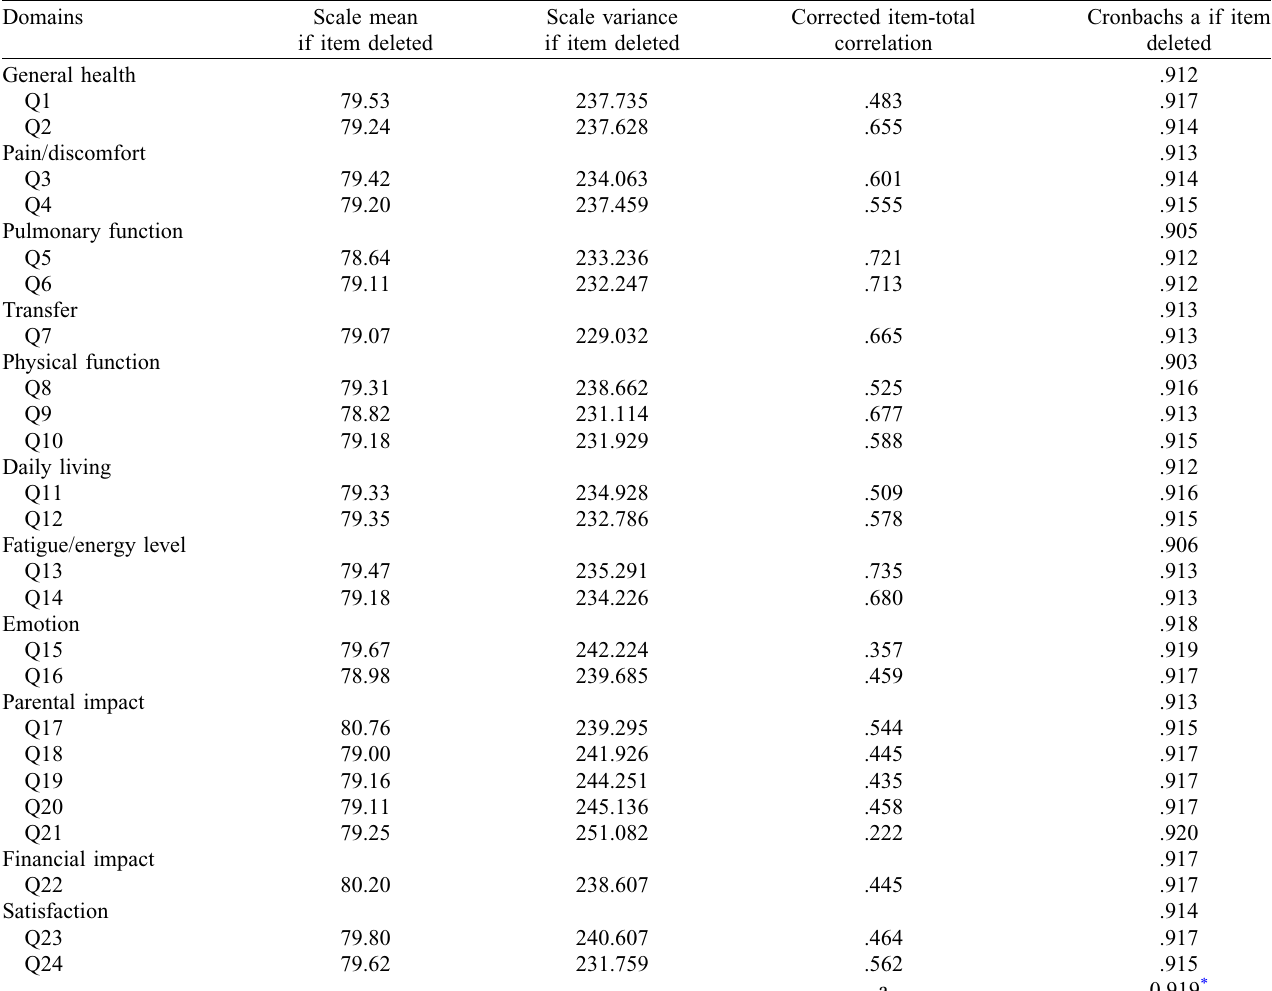
Table 2. Tests for Internal